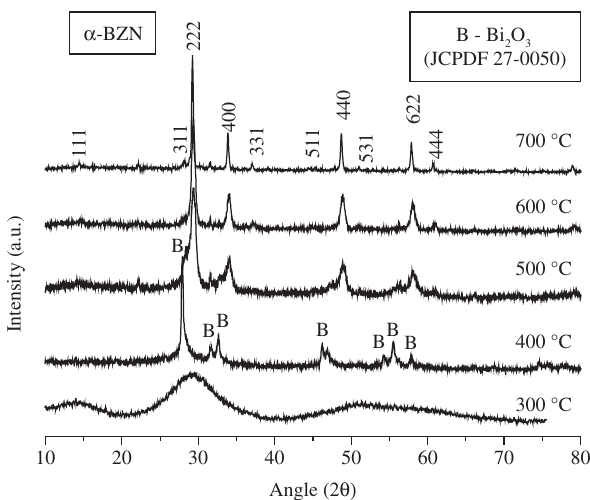
Figure 1. XRD patterns for the crystallization of α -BZN precursor. Samples were treated for 2 hours at indicated temperatures. B stands for Bi